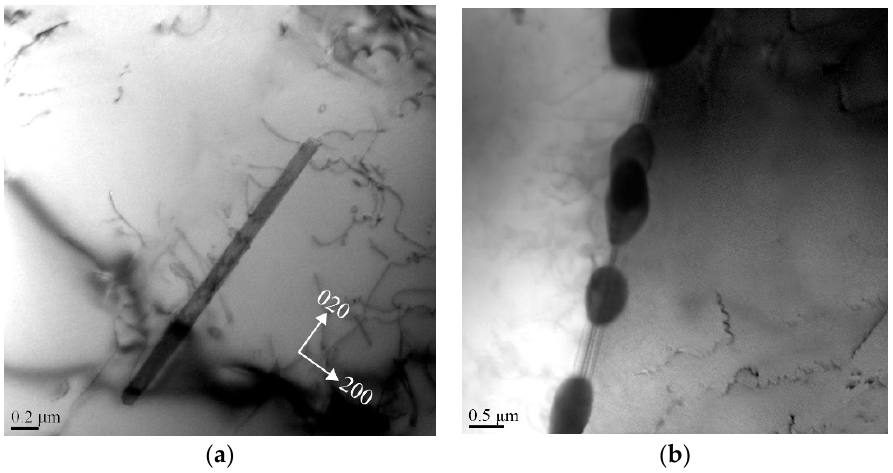
Figure 8. Bright-field transmission electron microscope (TEM) images of precipitates in the aluminum matrix ( a ) and along the grain boundary in the HPVD casting samples ( b ); isothermal holding at nose temperature (375 °C) for 300 s, recorded near [001] direction. Materials 2019 , 12 , x FOR PEER REVIEW